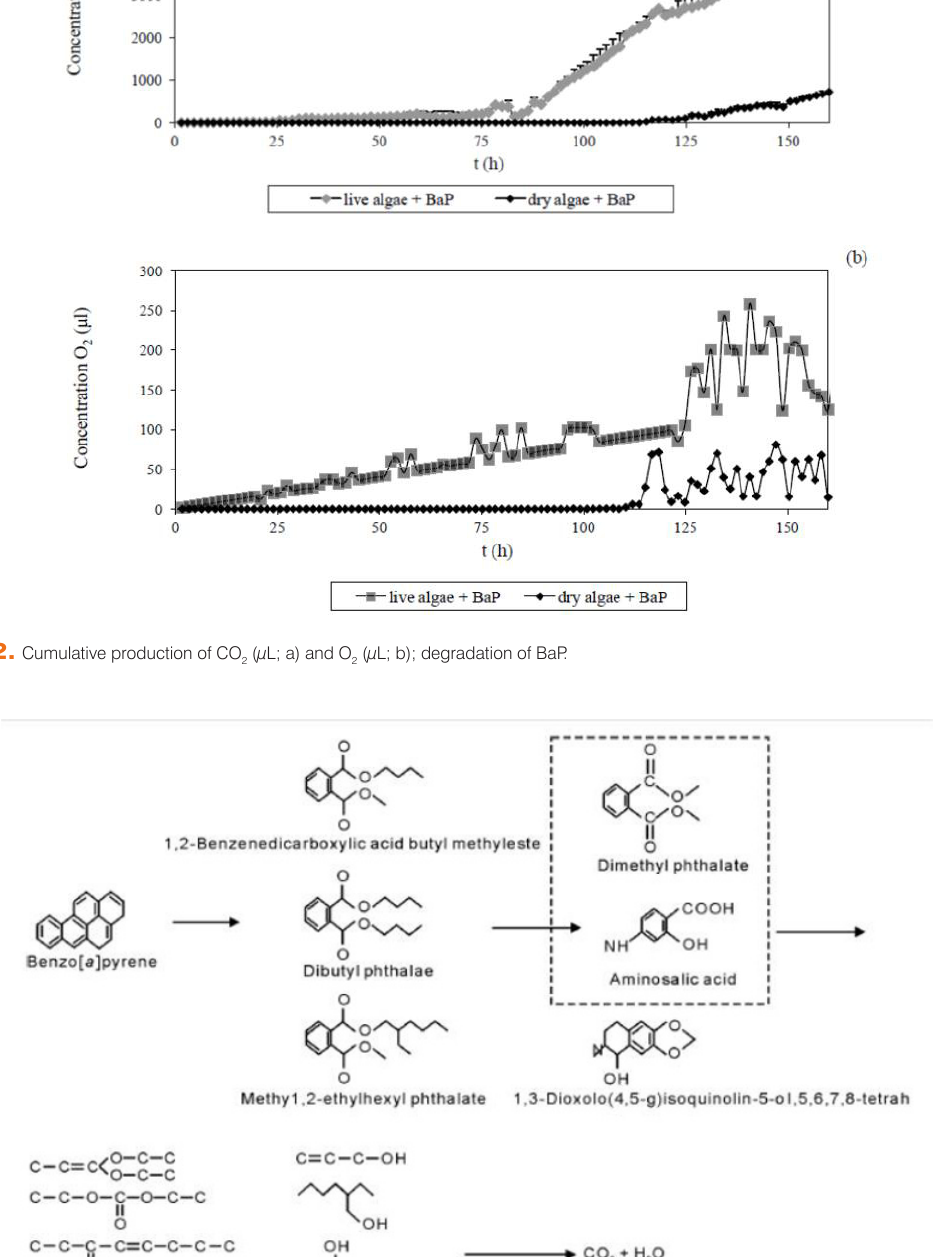
Figure 3. Degradation path of BaP by microorganism ( Arthrobacter oxydans (B4)